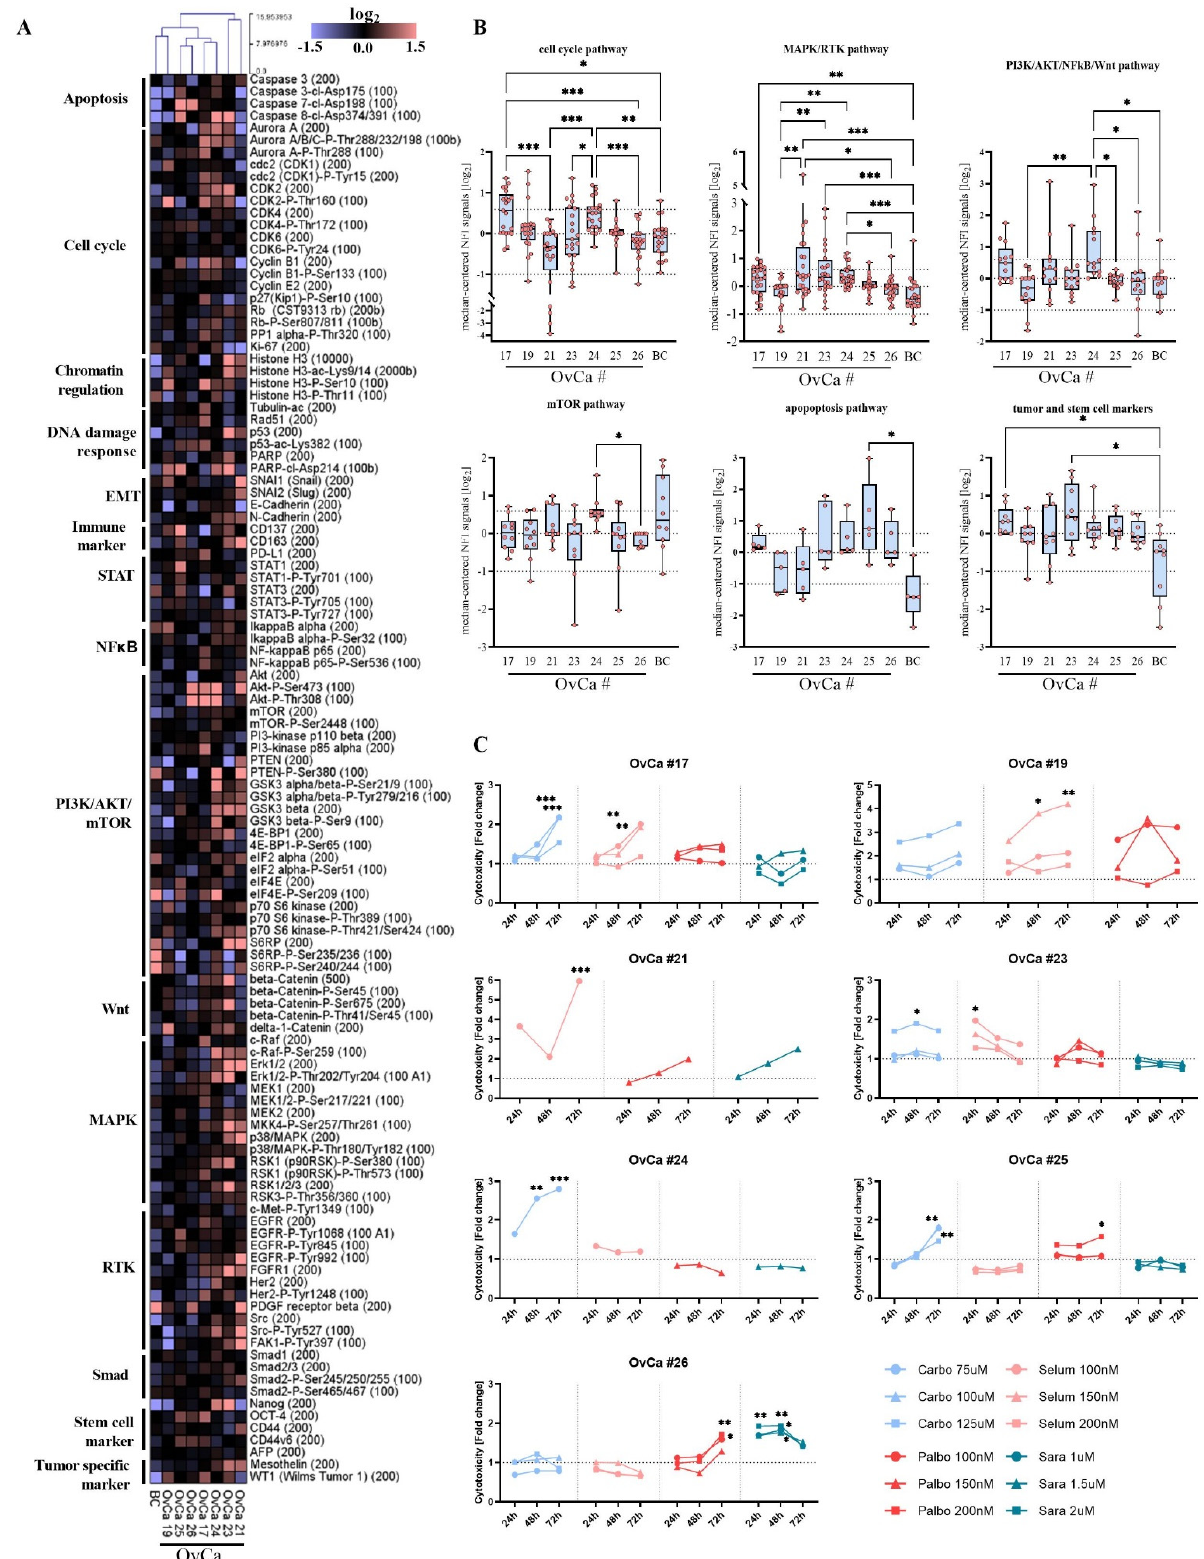
Figure 3. RPPA protein profiling of OvCa PDM identifies significant differences in active protein signaling pathways as molecular basis for OvCa PDM drug treatment responses. ( A ) Protein heat